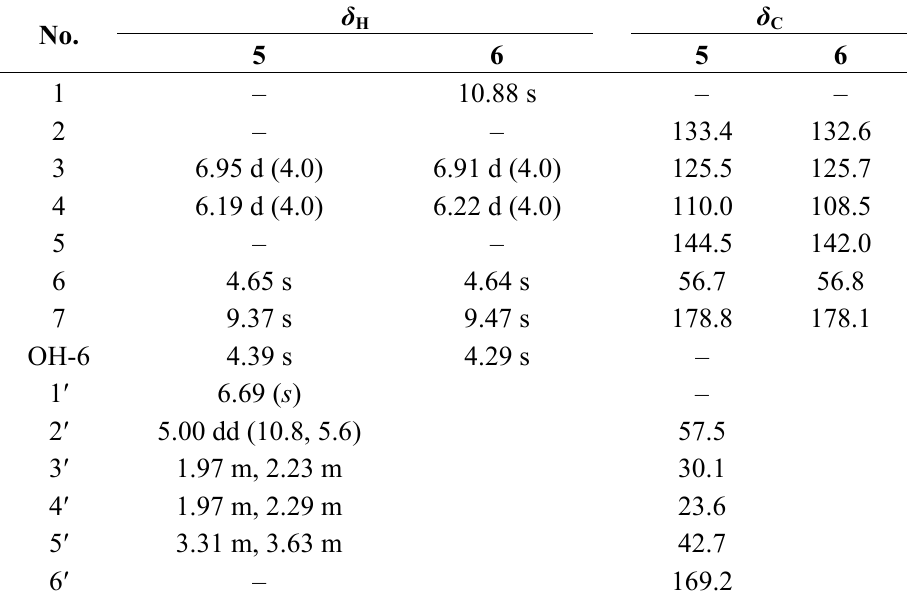
COCD , δ in ppm, J in Hz). 3 3